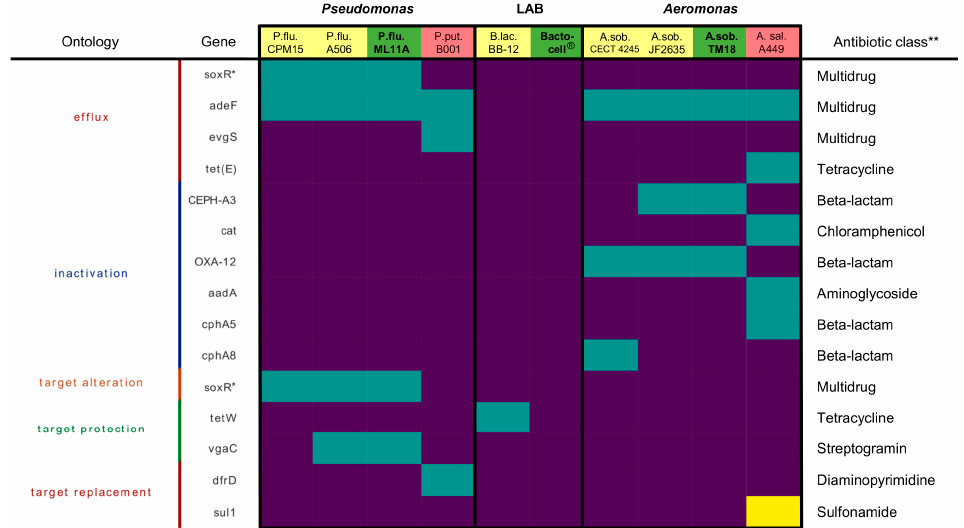
Figure 1. Presence / absence heatmap of antimicrobial resistance (AMR) genes present in bacterial strains of this study, as well as related strains. AMR genes categorized by Resistance Mechanism and samples have been clustered hierarchically. Yellow represents a perfect hit, teal represents a strict hit, purple represents no hit. Genes with asterisks (*) appear multiple times because they belong to more than one category in the antibiotic resistance ontology (ARO) database. ** Antibiotic classes were retrieved from the ARO database. LAB: Lactic acid bacteria. P.flu.: Pseudomonas fluorescens . P.put.: P.